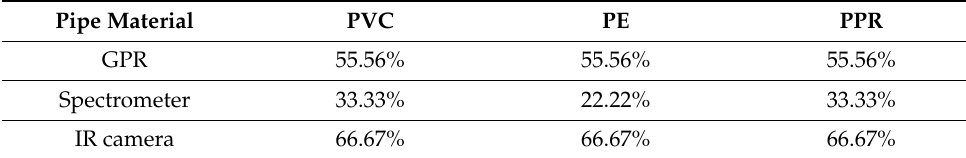
Table 9. Effect of pipe material on leak detection.